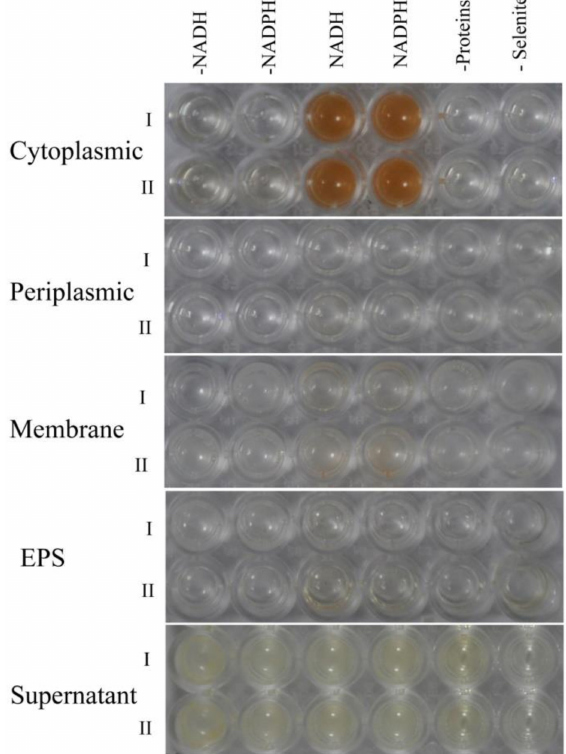
Figure 8. Selenite reduction assay on different subcellular fractions (cytoplasmic, periplasmic, and membrane), supernatant, and exopolysaccharide. All experiments were performed in duplicate (indicated by roman numbers), with addition of 5.0 mM SeO 32 − and 2.0 mM NADH or NADPH. While 3 following control negatives were performed: without protein fractions or supernatant or EPS, without selenite, without NADH or